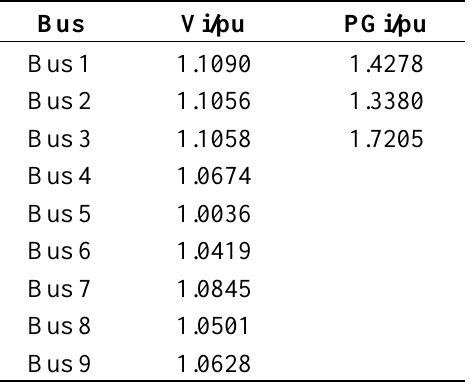
Table 7. OOP given by proposed method.